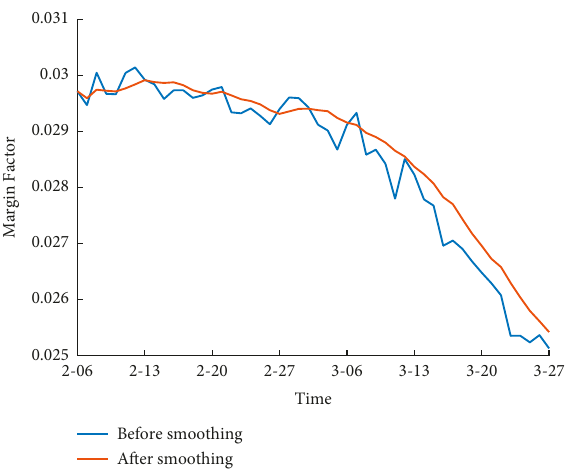
Figure 4: RMS feature smoothed curves before and after.